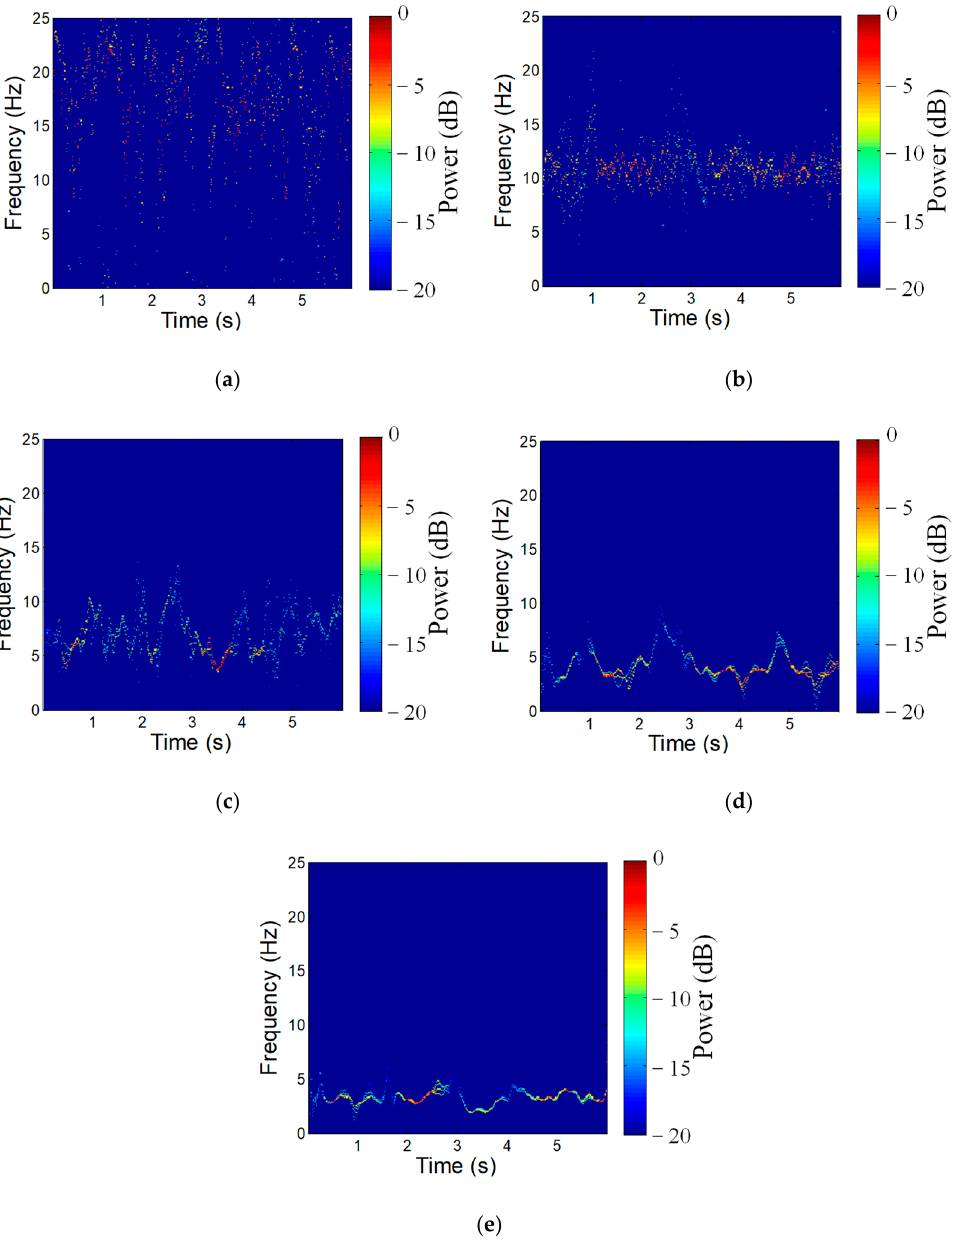
Figure 4. Hilbert spectrum of the first five IMFs. ( a ) IMF1; ( b ) IMF2; ( c ) IMF3; ( d ) IMF4; ( e ) IMF5.